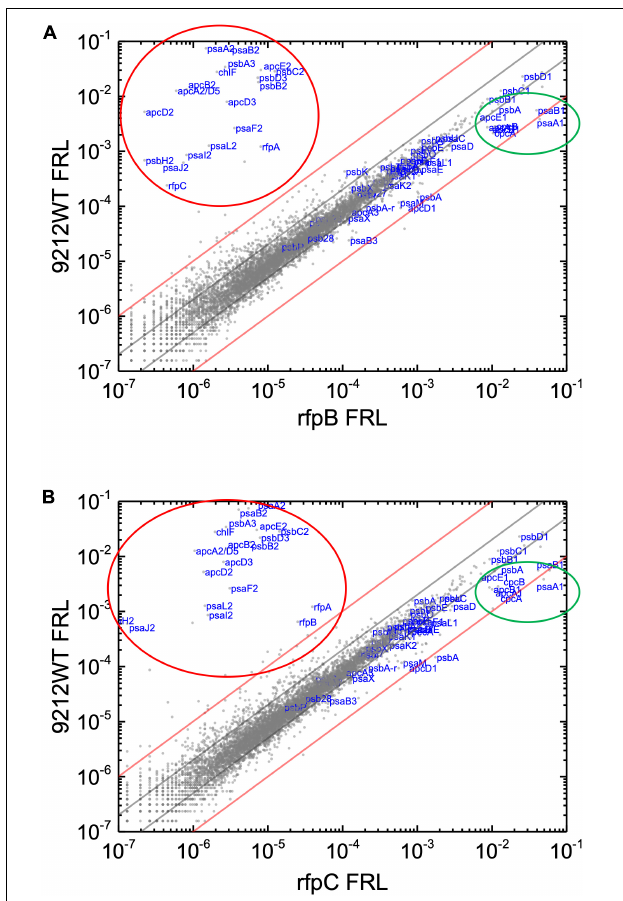
FIGURE 8 | Scatter plot showing a comparison of relative transcript abundances for C. fritschii 9212 cells of the WT and rfpB and rfpC mutants grown in FRL. The X - and Y -axes represent normalized transcript abundances in the WT and (A) rfpB mutant or (B) rfpC mutant grown in FRL, respectively. Each gray dot represents one gene. Genes of interest, including genes in FaRLiP gene cluster (red oval) and genes encoding PSI, PSII, and PBP/PBS subunits are labeled in blue font. The green circle shows some genes highly expressed in WT in WL, including apcE1 , cpcBA , and psaA1B1 . The gray and red diagonals indicate the thresholds for a 2-fold and 10-fold increase and a 50 and 10% reduction in relative transcript abundance,